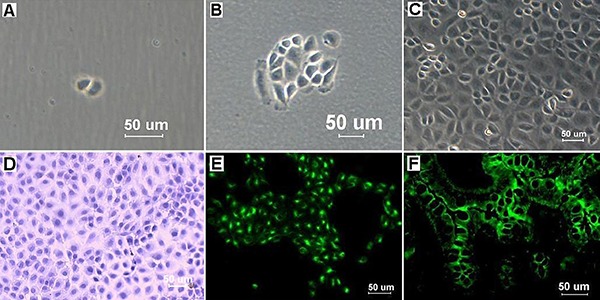
Preparation of cell clones and morphology characterization of mouse intestinal epithelial cells (IECs). Mouse IEC clones were obtained by limiting dilution, and light micrographs showed cell clones at 2 days (A) and 5 days (B) after seeding. The morphology of mouse IECs at the 35th passage is shown in (C). Hematoxylin and eosin staining showed that mouse IECs formed a cobblestone monolayer, and each cell was polygonal and flattened with a large, oval nucleus (D). The mouse IECs were strongly positive for cytokeratin 18 (E), and the mouse intestinal tissues also reacted with the cytokeratin 18 antibodies as the positive control (F).